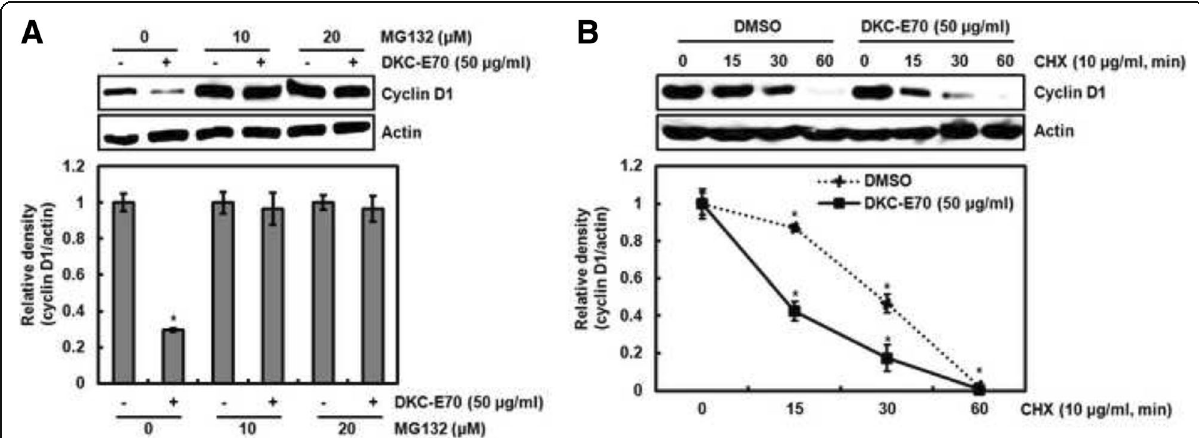
Fig. 3 DKC-E70 mediates cyclin D1 degradation. a HCT116 cells were pretreated with MG132 at the indicated concentration for 2 h, and then co-treated with DKC-E70 (50 μ g/ml) for 10 h. Cell lysates were subjected to SDS-PAGE and the Western blot was performed using antibody against cyclin D1. b HCT116 ells were pretreated with DMSO or DKC-E70 (50 μ g/ml), and then co-treated with 10 μ g/ml of cycloheximide (CHX) for the indicated times. Cell lysates were subjected to SDS-PAGE and the Western blot was performed using antibody against cyclin D1.Actin was used as internal control for Western blot analysis. *P < 0.05 compared to cell without DKC-E70